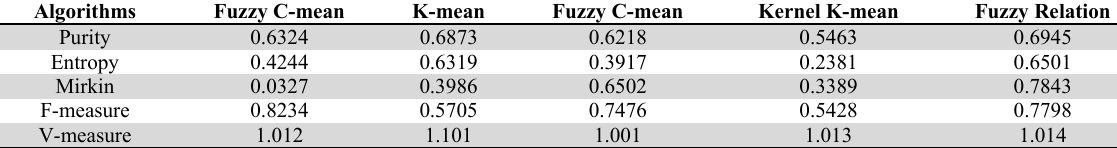
Average values of the validity indices for Clustering Algorithms